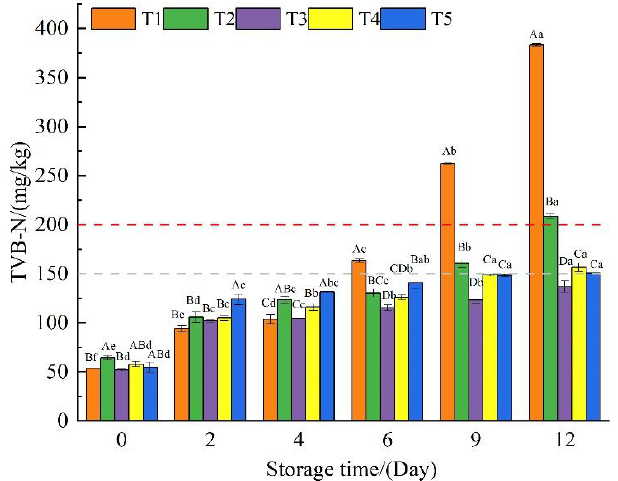
Figure 4. The total volatile base nitrogen of beef samples from different treatment groups